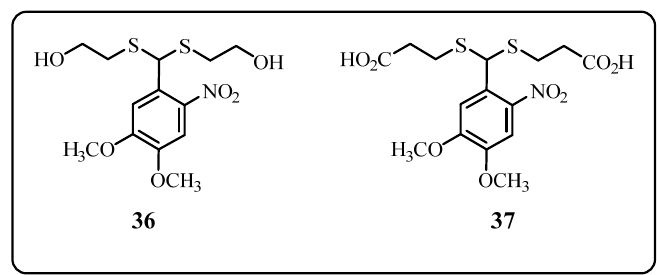
Figure 5. The structures of TNB photocages.